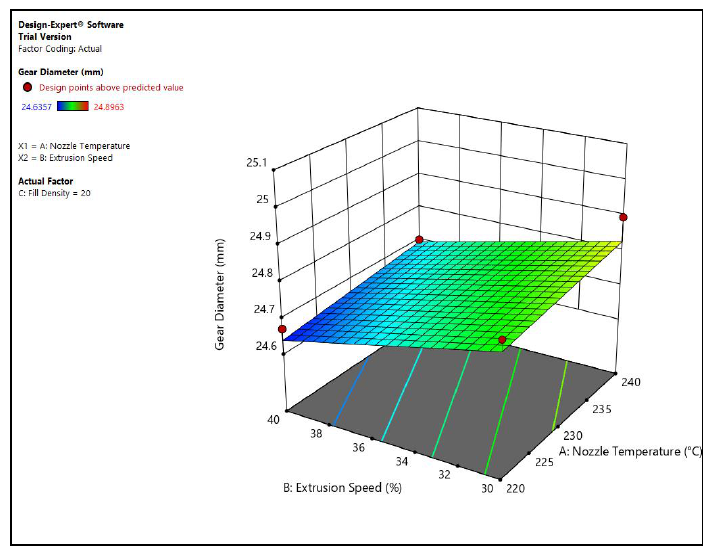
Fig. 5. Interaction effect analysis of factor A and B for the gear bore